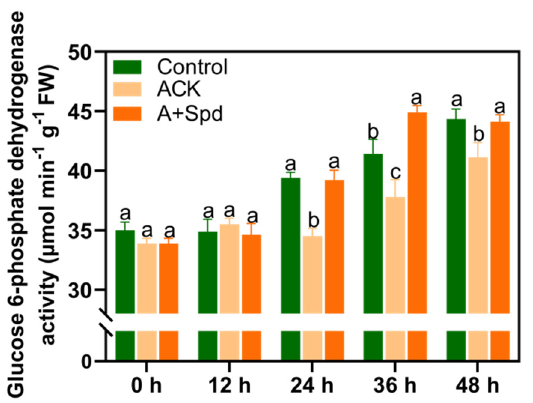
Figure 7. Exogenous Spd enhances the activities of key enzymes in the PPP during germination of aged seeds. Control − healthy seeds; ACK − artificially aged seeds; A+Spd − aged seeds with Spd treatment. A total of five time points from 0 to 48 h after germination were performed for each treatment. Different lowercase letters above the bars indicate significant levels of difference among the three treatments ( p < 0.05, Lsd). A 0.05 μ M concentration of exogenous Spd was used.